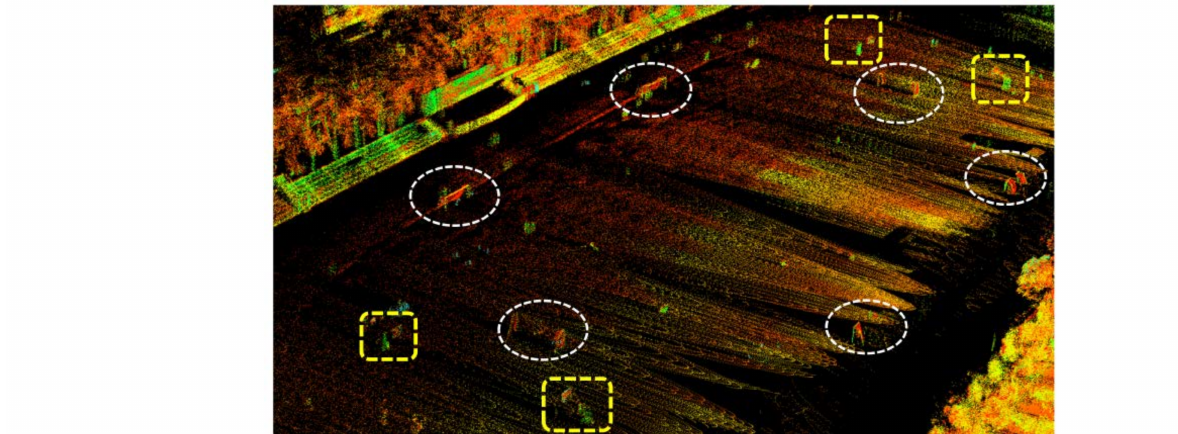
Figure 10. Evaluation of mapping and odometry results for experiment